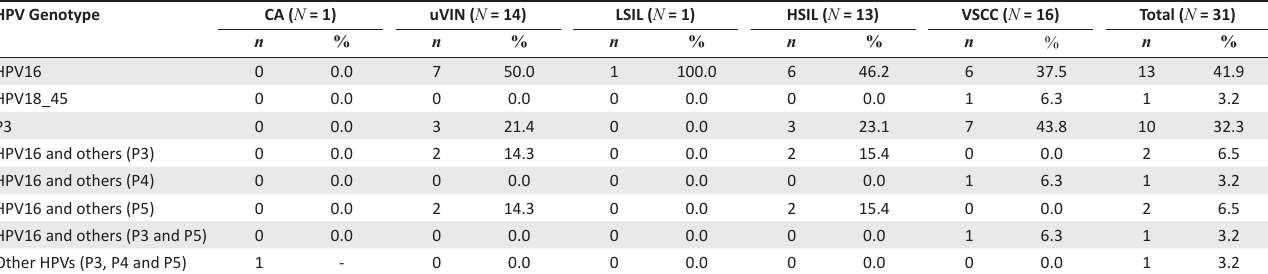
TABLE 3: Frequency of high-risk human papillomavirus genotypes among women with condylomata acuminatum, uVIN and VSCC at the University Teaching Hospital’s gynaecologic clinic, Zambia,